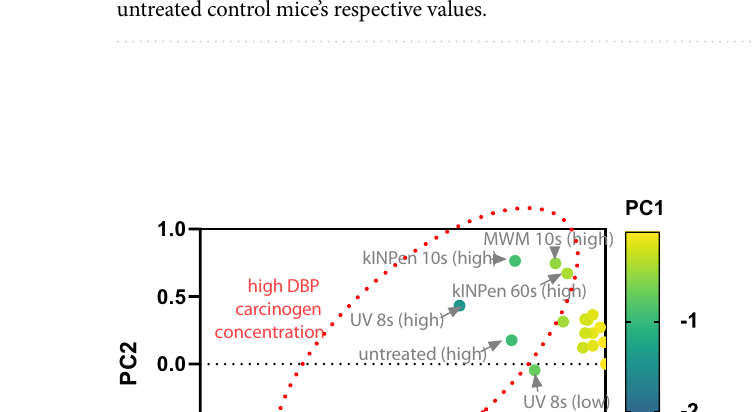
Figure 6. Gene expression analysis of 49 transcripts expressed and identified across all groups. ( a ) classification of identified genes across sorted by their occurrence within functions, pathways, and classes; ( b ) heatmap of relative gene expression for all targets and groups. Data are mean from duplicates of RNA pooled from the mucosa of 5 mice per group and normalized to the house-keeper GAPDH before the second normalization of untreated control mice’s respective values.